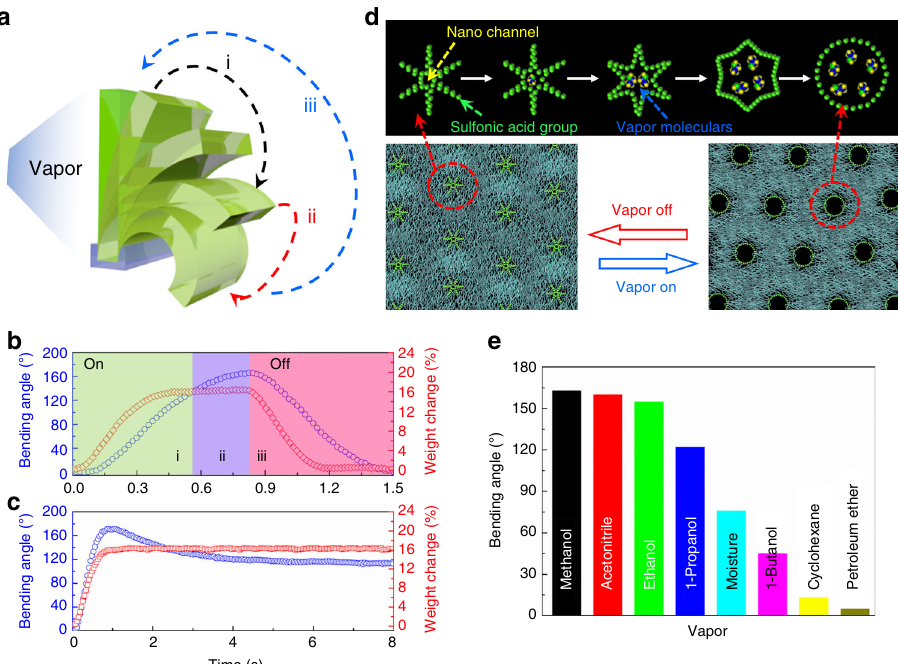
Fig. 3 Actuation mechanism of the nano channel membrane. a Schematic representation of the vapor-responsive bending principle of the actuator (when vapor approaches one side of the single-layer membrane, the molecular channel adsorbs the vapor and the surface undergoes swelling, resulting in the fi lm bending upon exposure to the vapor source). b Single-layer membrane bending and reversing actuation synchronizes with weight change when the vapor was pumped in and out. c Single-layer membrane bending behavior with weight change when the vapor was retained in the chamber. d Schematic representation of the molecular channel expansion process. e Maximum bending angles of the single-layer PFSA actuator triggered by various solvent vapors. (2 kPa, 20